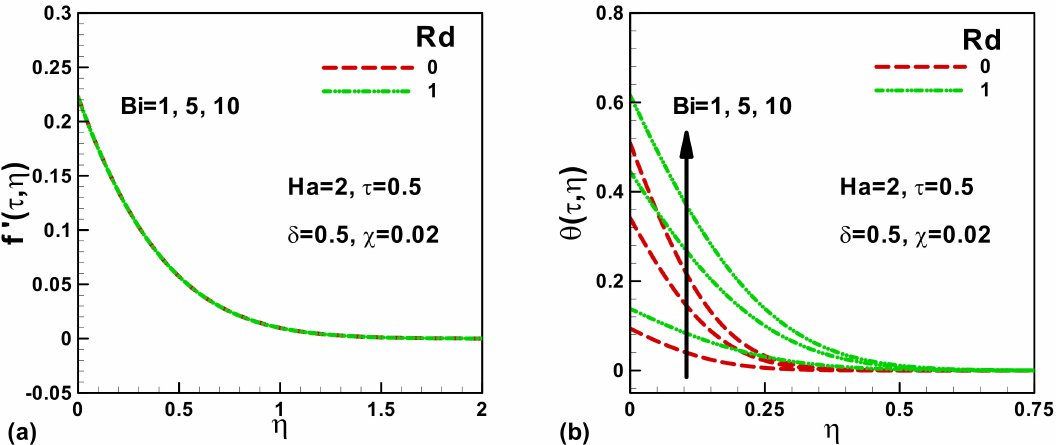
Figure 3. E ff ects of Biot number Bi and radiation parameter Rd on ( a ) dimensionless velocity and ( b ) dimensionless